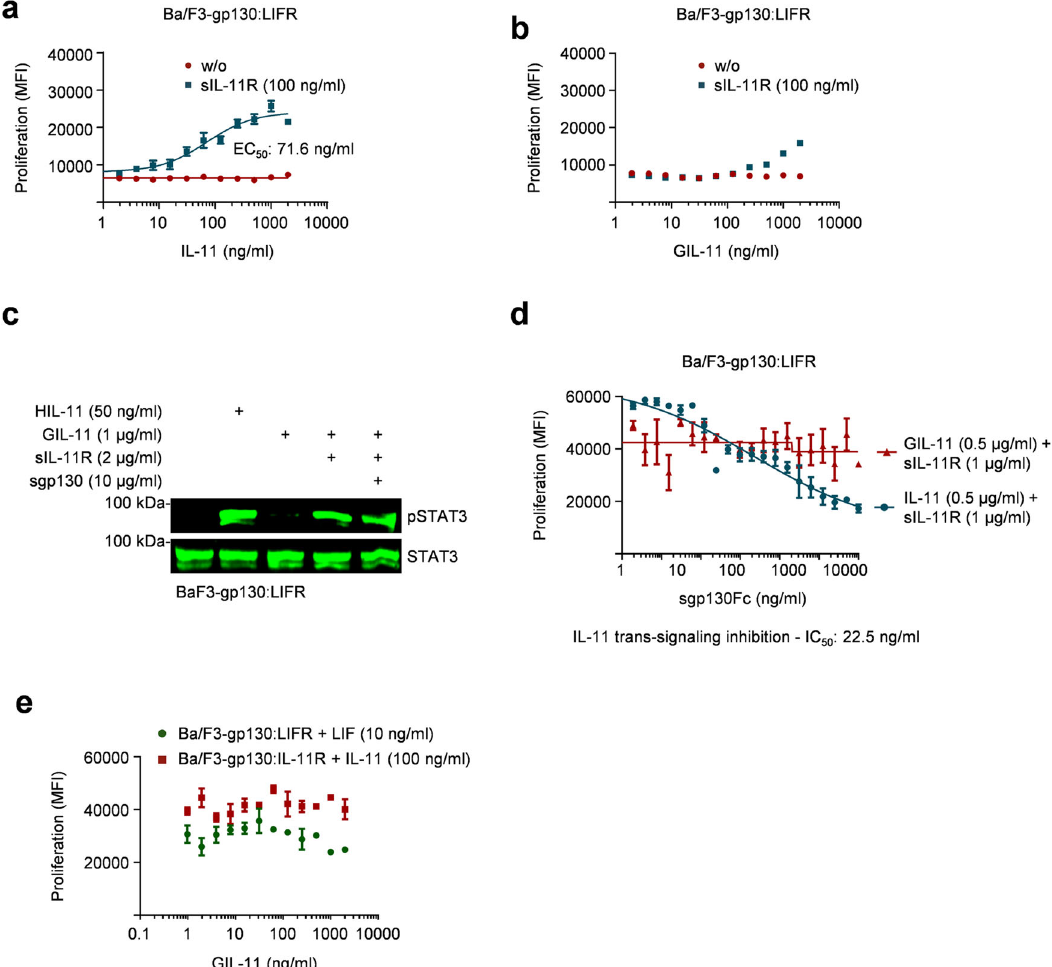
Fig. 5 GIL-11:sIL-11 complexes induce trans-signaling via gp130:LIFR. a Proliferation of Ba/F3-gp130:LIFR cells in the presence and absence of fi xed concentrations of sIL-11R (0 or 100 ng/ml) and increasing concentrations of IL-11 (1 – 2000 ng/ml). One representative experiment out of three is shown. b Proliferation of Ba/F3-gp130:LIFR cells in the presence and absence of fi xed concentrations of sIL-11R (0 or 100 ng/ml) and increasing concentrations of GIL-11 (1 – 2000 ng/ml). One representative experiment out of three is shown. c STAT3 activation in Ba/F3-gp130:LIFR cells without cytokine (-) and after stimulation with HIL-11 (50 ng/ml), GIL-11 (1 µ g/ml), GIL-11 (1 µ g/ml):sIL-11R (2 µ g/ml), GIL-11 (1 µ g/ml):sIL-11R (2 µ g/ml):sgp130Fc (10 µ g/ml) for 15 min. Equal amounts of proteins (50 µ g/lane) were analyzed via speci fi c antibodies detecting phospho-STAT3 and STAT3. Western blot data shows one representative experiment out of three. d Proliferation of Ba/F3-gp130:LIFR cells in the presence and absence of fi xed concentrations of IL-11 (0.5 µ g/ ml):sIL-11R (1 µ g/ml) or GIL-11 (0.5 µ g/ml):sIL-11R (1 µ g/ml) and increasing concentrations of sgp130Fc (1 – 10,000 ng/ml). One representative experiment out of three is shown. e Proliferation of Ba/F3-gp130:LIFR cells in the presence and absence of fi xed concentrations of LIF (10 ng/ml) and increasing concentrations of GIL-11 (1 – 2000ng/ml) (green). Proliferation of Ba/F3-gp130:IL-11R cells in the presence and absence of fi xed concentrations of IL-11 (100 ng/ml) and increasing concentrations of GIL-11 (1 – 2000 ng/ml) (red). Error bars de fi ne ±SEM. One representative experiment with three biological replicates out of three is